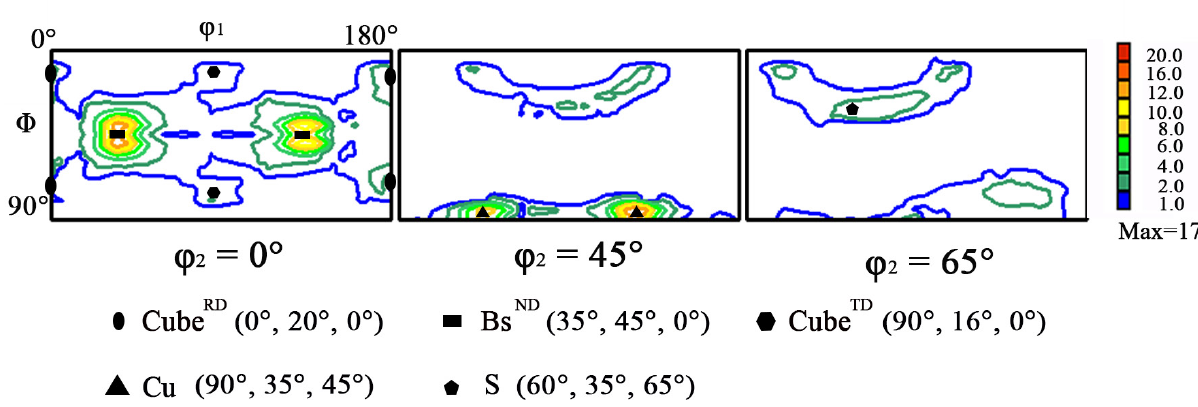
Figure 4: φ 2 = 0 ∘ , 45 ∘ , 65 ∘ sections for the cross cold rolling